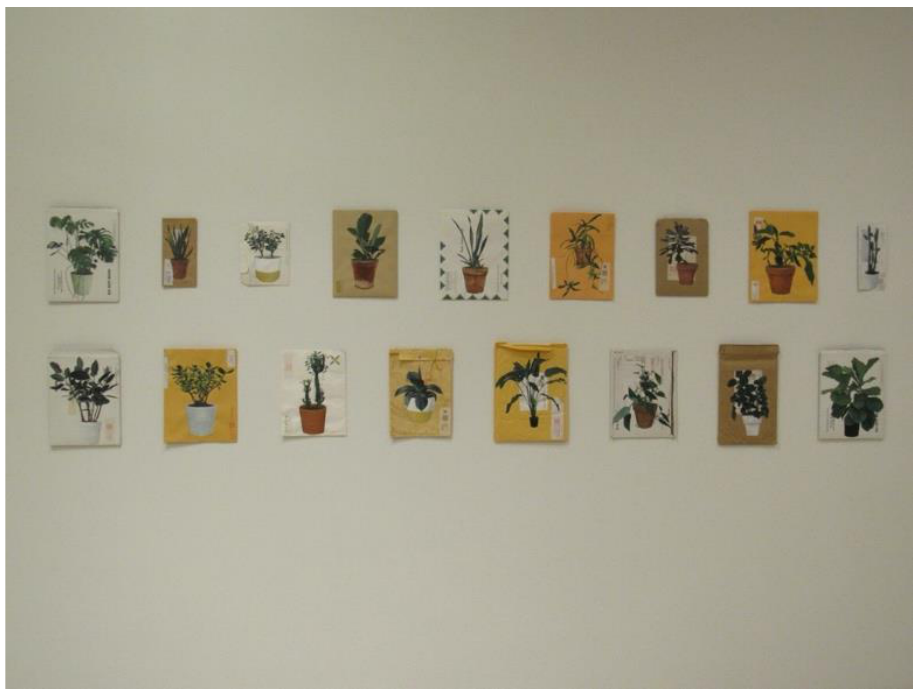
Figure 10 Fidencio Fifield-Pérez, Dacaments 1-17 (2017-2019). Acrylic on paper (Photo: